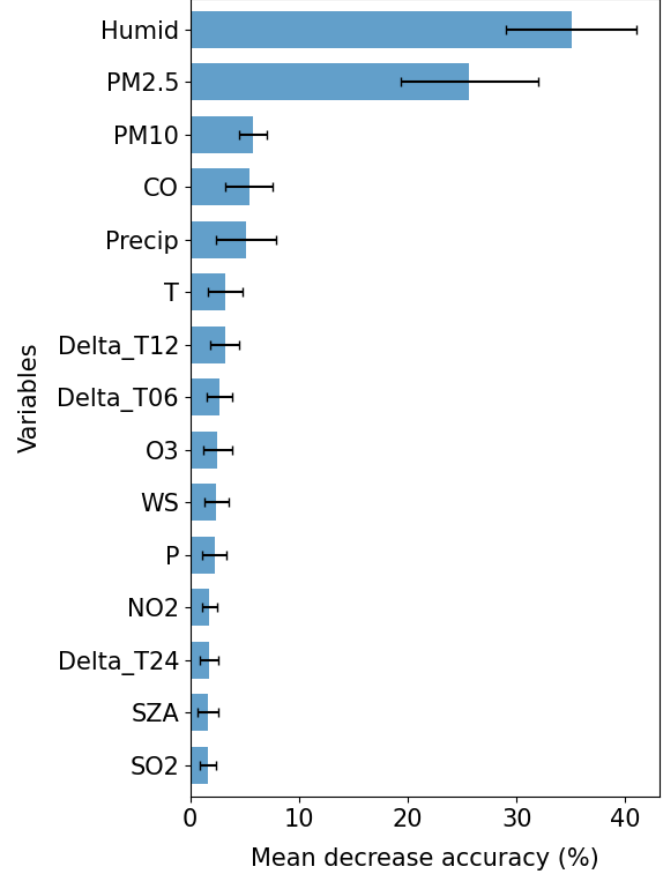
Figure 6. Spatially averaged variable importance (mean decrease accuracy) of visibility estimation model. The error bar indicates the standard deviations.